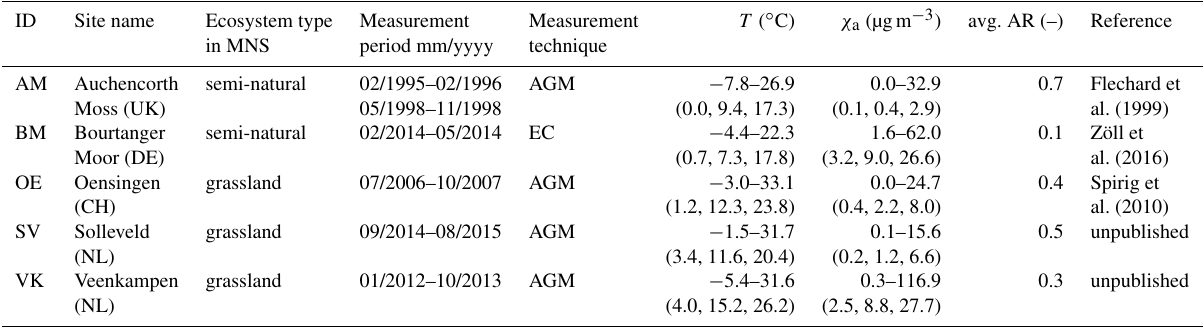
Figure 2. Theoretical considerations about the non-stomatal resistance parameterizations’ response to changes in micrometeorological con- ditions. (a) Non-stomatal resistance ( R w ) as a function of (a 1 ) relative humidity (RH) and (a 2 ) temperature ( T ) for different ecosystems and pollution climates according to the Massad et al. (2010) parameterization. (b) Non-stomatal compensation point ( χ w ) as a function of air ammonia concentration ( χ a ) and temperature ( T ) in the Wichink Kruit et al. (2010) parameterization. Table 1. Summary of the five datasets. AGM = aerodynamic gradient method; EC = eddy covariance, MNS = Massad et al. (2010). Mea- surement period is the period during which flux measurements were available after final data filtering. T and χ a ranges are minimum and maximum values during the measurement period and values in parentheses denote the 5, 50, and 95%